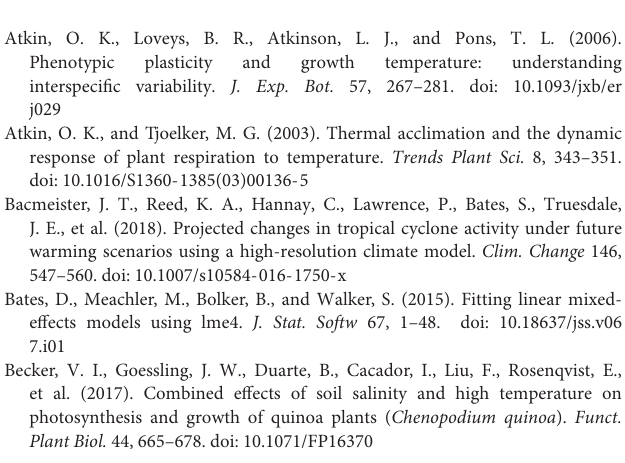
Supplementary Figure 1 | A-C i curves at different temperatures. Supplementary Figure 2 | Gain score analysis of heated and control plot vegetation temperature and soil moisture. Supplementary Figure 3 | VPD of heated and control plots during summer 2017. Supplementary Figure 4 | Photosynthetic parameter gain scores between pre-warming and post-warming measurements. Supplementary Figure 5 | Dark respiration parameter gain scores between pre-warming and post-warming measurements. Supplementary Figure 6 | Biochemical parameter responses to leaf temperature. Supplementary Figure 7 | Photosynthetic parameter responses to maximum daily vegetation temperature. Supplementary Figure 8 | Respiratory parameter responses to minimum daily vegetation temperature. Supplementary Figure 9 | Photosynthetic parameter responses to soil moisture at 0–10 cm depth. Supplementary Figure 10 | Respiratory parameter responses to soil moisture at 0–10 cm depth. Supplementary Figure 11 | Hierarchical partitioning results of gas exchange parameter variances explained by environmental variables. Supplementary Table 1 | Mean daily vegetation temperature of the control plots, mean, minimum, and maximum daily air temperature and rainfall during each measurement campaign. Supplementary Table 2 | Count of total individual trees and leaves measured for each campaign, species, treatment, and gas exchange measurement. Supplementary Table 3 | P -values and degrees of freedom from ANOVA results of gain score of vegetation temperature and soil moisture. Supplementary Table 4 | P -values and degrees of freedom from ANOVA results of gain score of leaf gas exchange variables. Supplementary Table 5 | Mean daily maximum vegetation temperature and physiological parameter means of the heated and control plots for each species. Supplementary Table 6 | Temperature response parameters estimated for the maximum rate of Rubisco carboxylation ( V cmax ) and the maximum rate of electron transport ( J max ). Supplementary Table 7 | Summary of mixed effects model results of gas exchange parameter responses to environmental